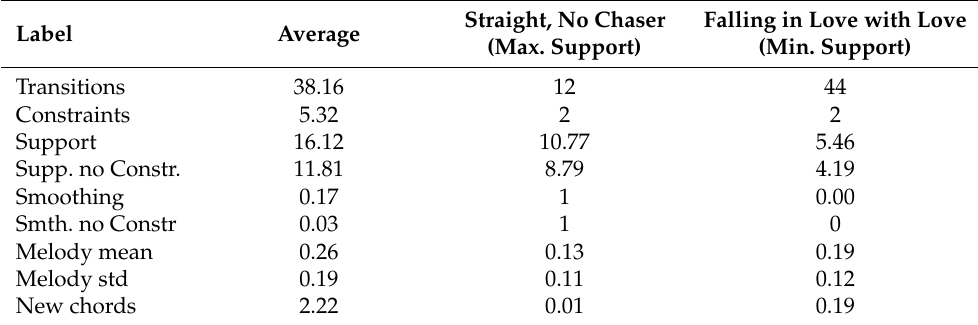
Table 2. Statistics of applying support and chord grouping when a piece acts as Song A, i.e., when it provides the melody and the